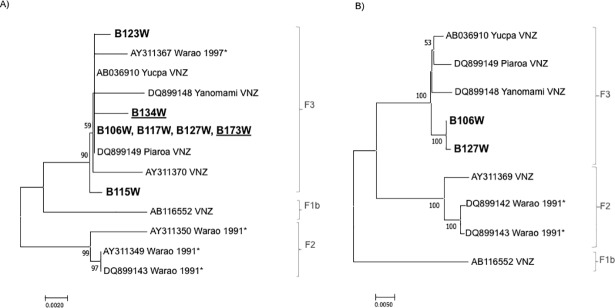
Phylogenetic tree of HBV isolated from Amerindian Warao population.A) Phylogenetic analysis of HBV S region (658 bp) and B) of two complete genome HBV isolated of Amerindian Warao population. Genetic distance was estimated by Kimura two parameters correction, MEGA version 7.0.26. Phylogenetic tree was constructed with the Neighbour-joining method. Numbers at each node correspond to bootstrap values (>50%) obtained with 1000 replicates. The prototype strains are designated by their GenBank accession number, and country or ethnic group, except the Warao isolates of this study (bold). VNZ: Venezuela. *These Warao isolates were obtained between the years 1991–1997 and analyzed in a previous study [34]. The sequences of occult HBV infection are underlined. Six isolates for which only a 330 pb fragment could be amplified are not included in the tree.